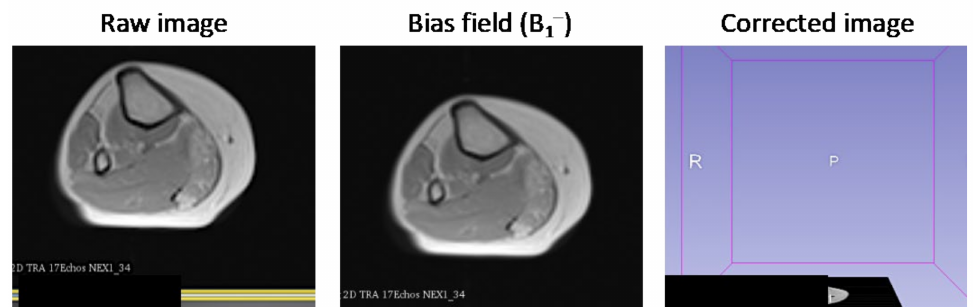
Figure 3. Correcting receiver gain bias in an axial MRI of the calf. Left: Image affected by inhomoge- neous B 1– intensity bias; Middle: bias field, estimated using the N4ITK method; Right: image after intensity